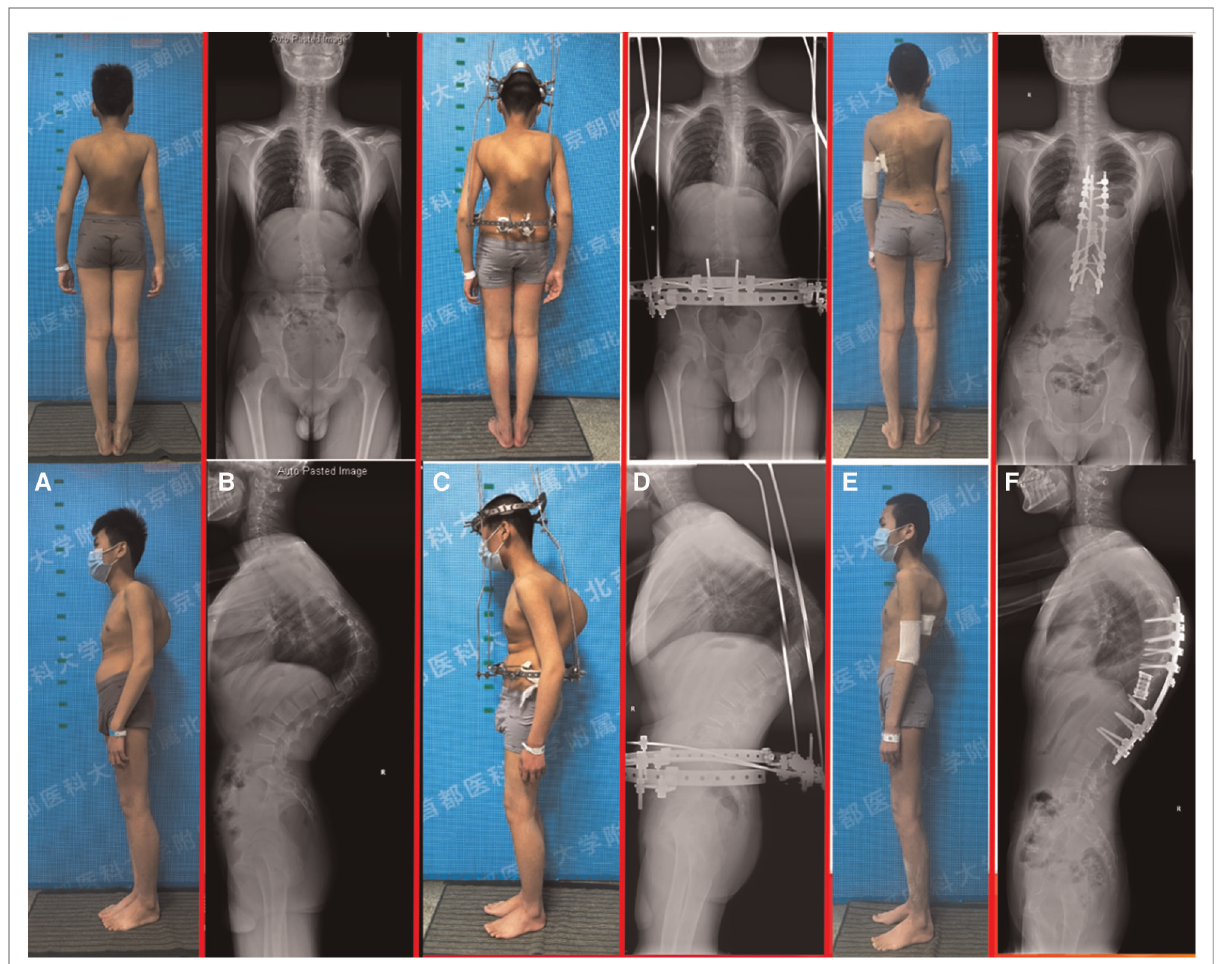
FIGURE 3 A 13-year-old male with progressive kyphosis and massive osteolysis in the thoracic vertebrae. ( A ) patient ’ s preoperative appearance; ( B ) preoperative standing whole-spine radiograph demonstrated a thoracic kyphosis curve of 122°; ( C ) patient ’ s halo-pelvic traction appearance; ( D ) standing whole- spine radiograph after halo-pelvic traction; ( E ) patient ’ s postoperative appearance; ( F ) postoperative standing whole-spine radiograph demonstrated the thoracic kyphosis was reduced to 48°, with a correction rate of